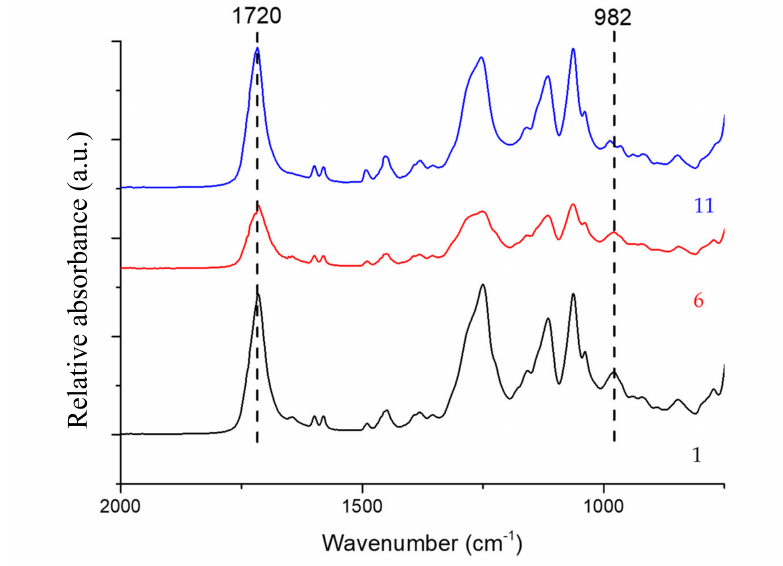
Figure 3. FTIR spectra of samples cured according to parameters 1, 6, and